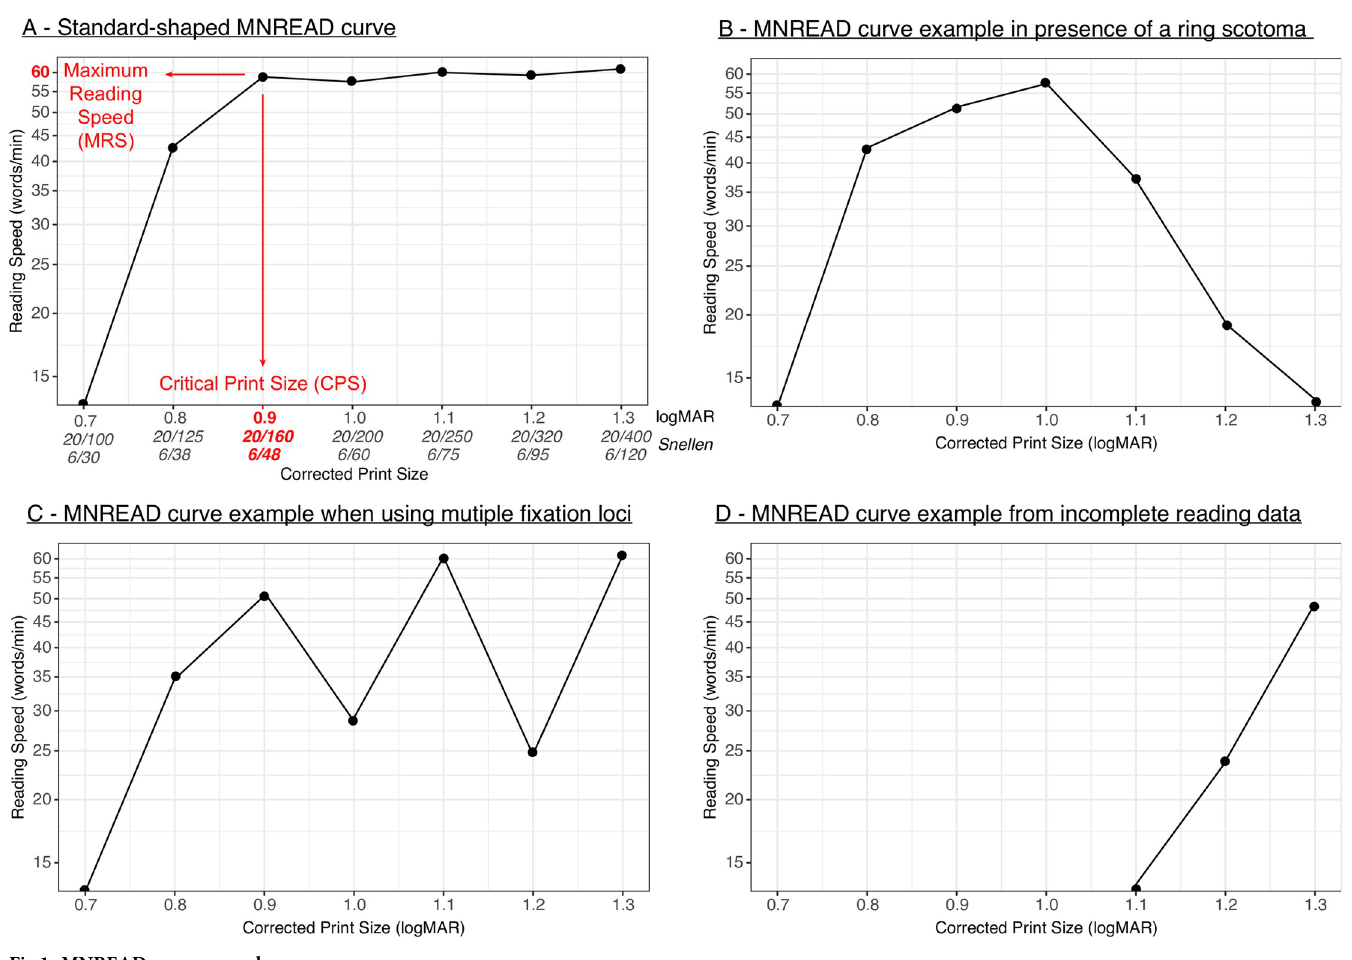
Fig 1. MNREAD curve